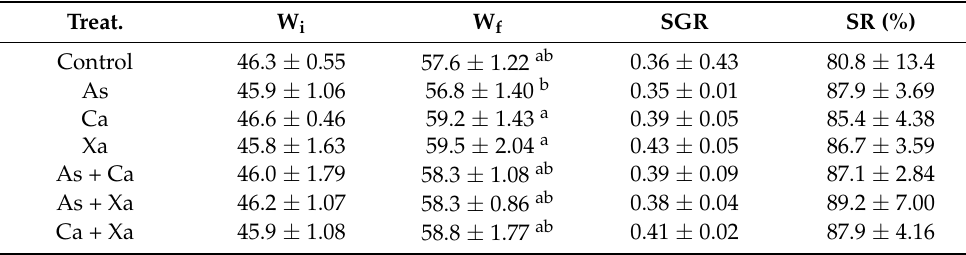
Table 2. Growth performance, initial weight (W i , g/fish), final weight (W f , g/fish), specific growth rate (SGR, %/day), and survival rate (SR, %) of fish fed dietary pigments for 6 weeks.